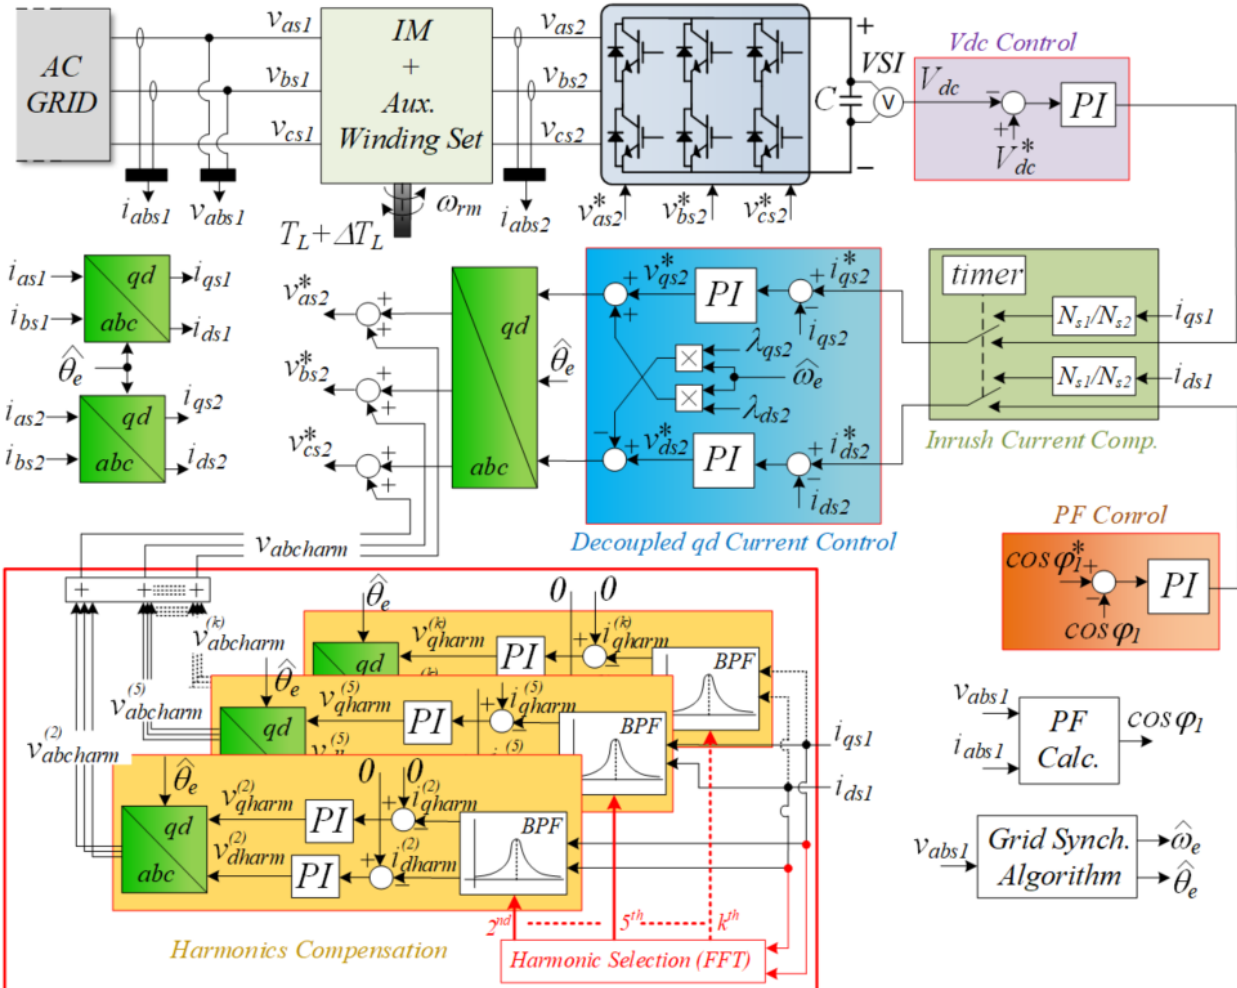
Figure 3. Block diagram of the proposed direct online (DOL) DWIM control solution.